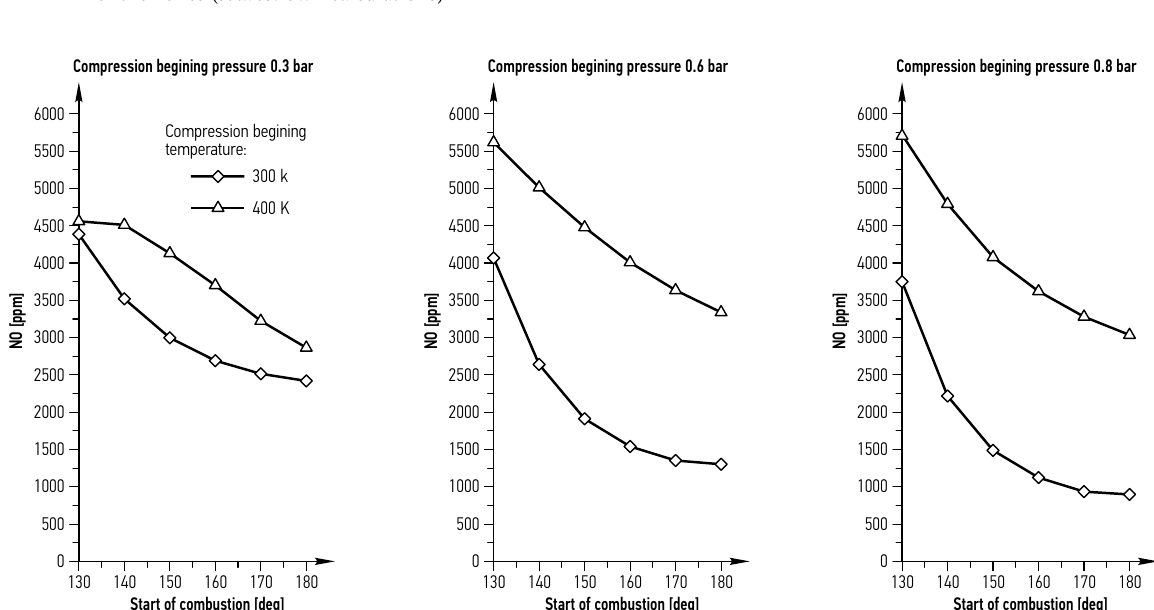
Fig. 6. NO emission as a function of combustion starting at different commencing pressures of compression ( source : own calculations)